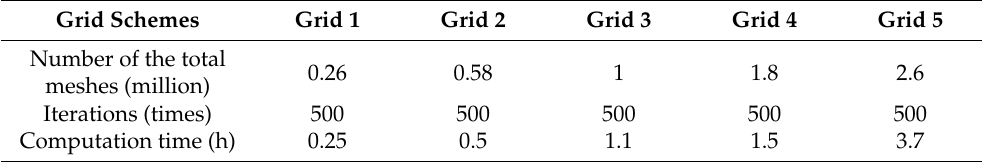
Table 2. The computation time of different grid schemes for Autodesk CFD.